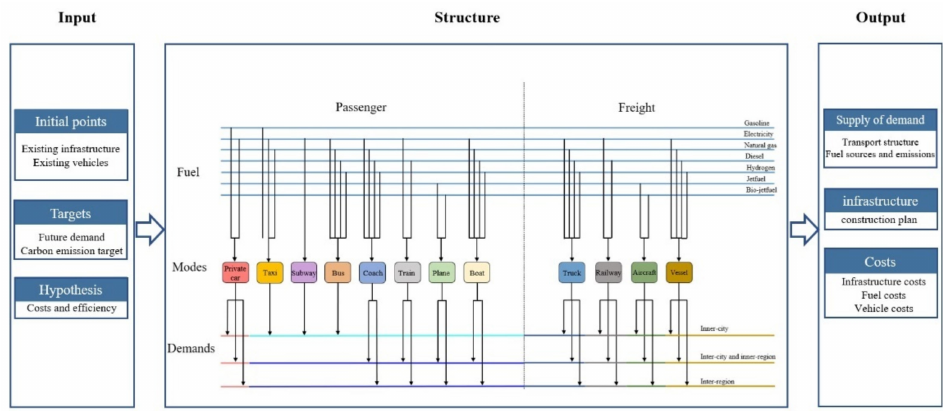
Figure 2. The framework of the